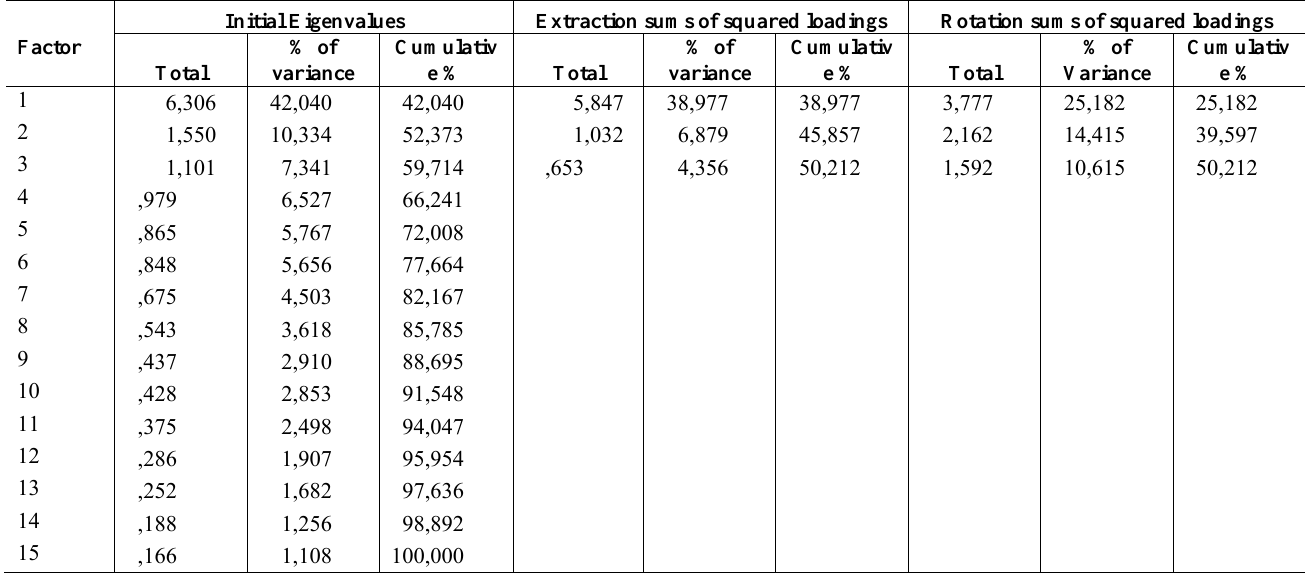
Table 3: Total variance explained